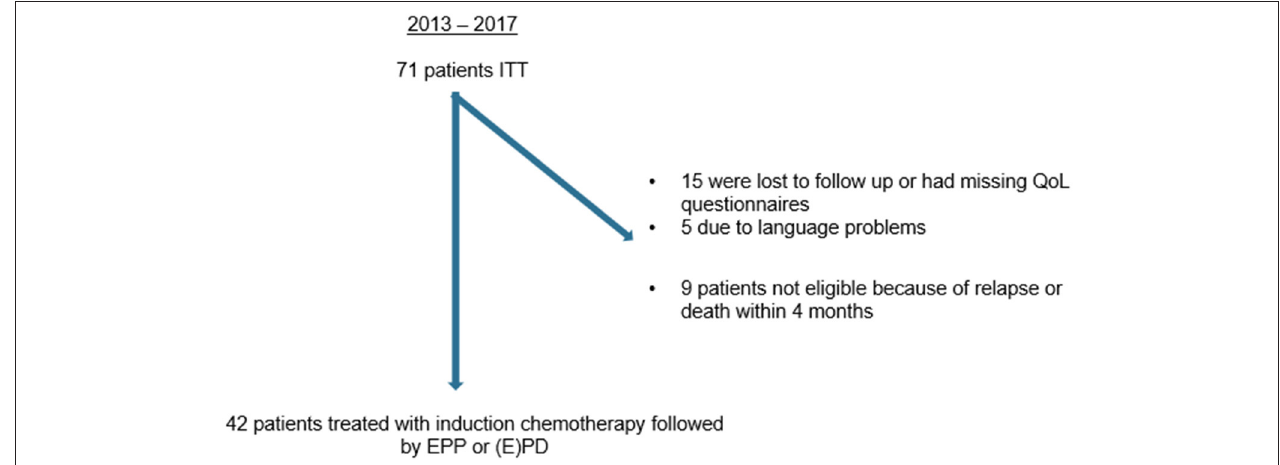
FIGURE 1 | Flow chart. ITT, indented to be treated.